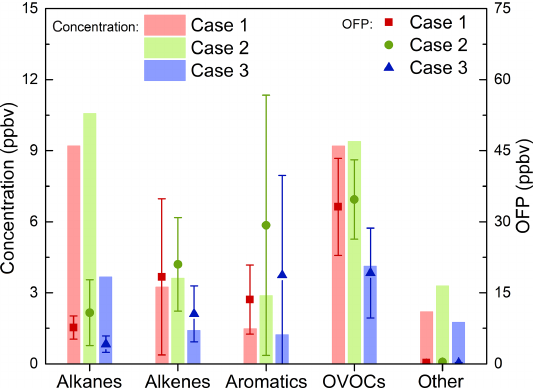
Figure 7. Average mixing ratios and OFP (ozone formation poten- tial) of five VOC groups for the three